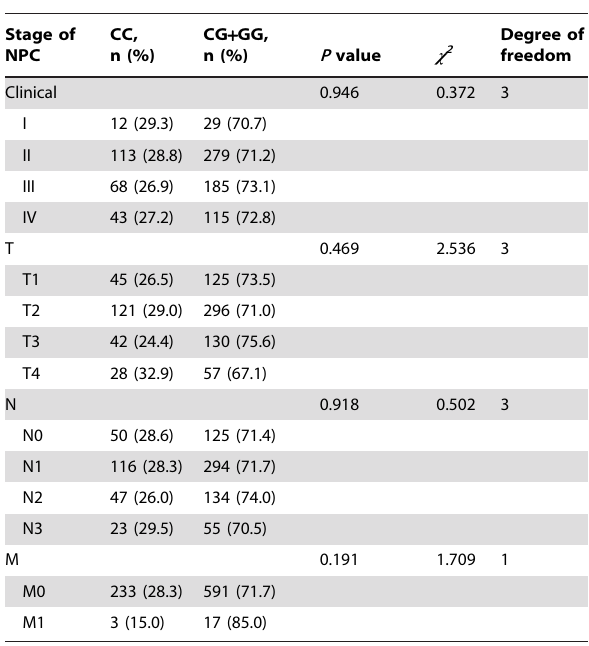
Table 3. Distributions of genotypes of the BIRC5 -31C/G polymorphism among the subgroups with different severity of NPC in the Guangxi population